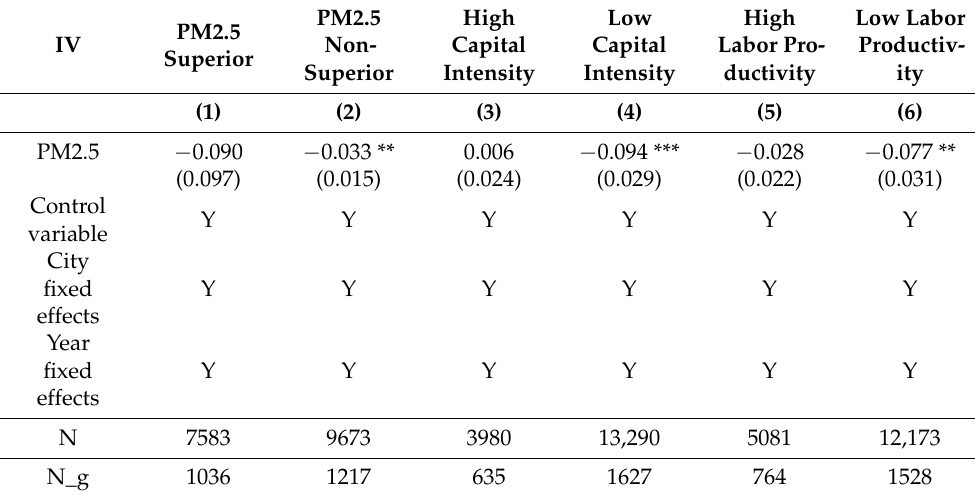
Table 12. Heterogeneity